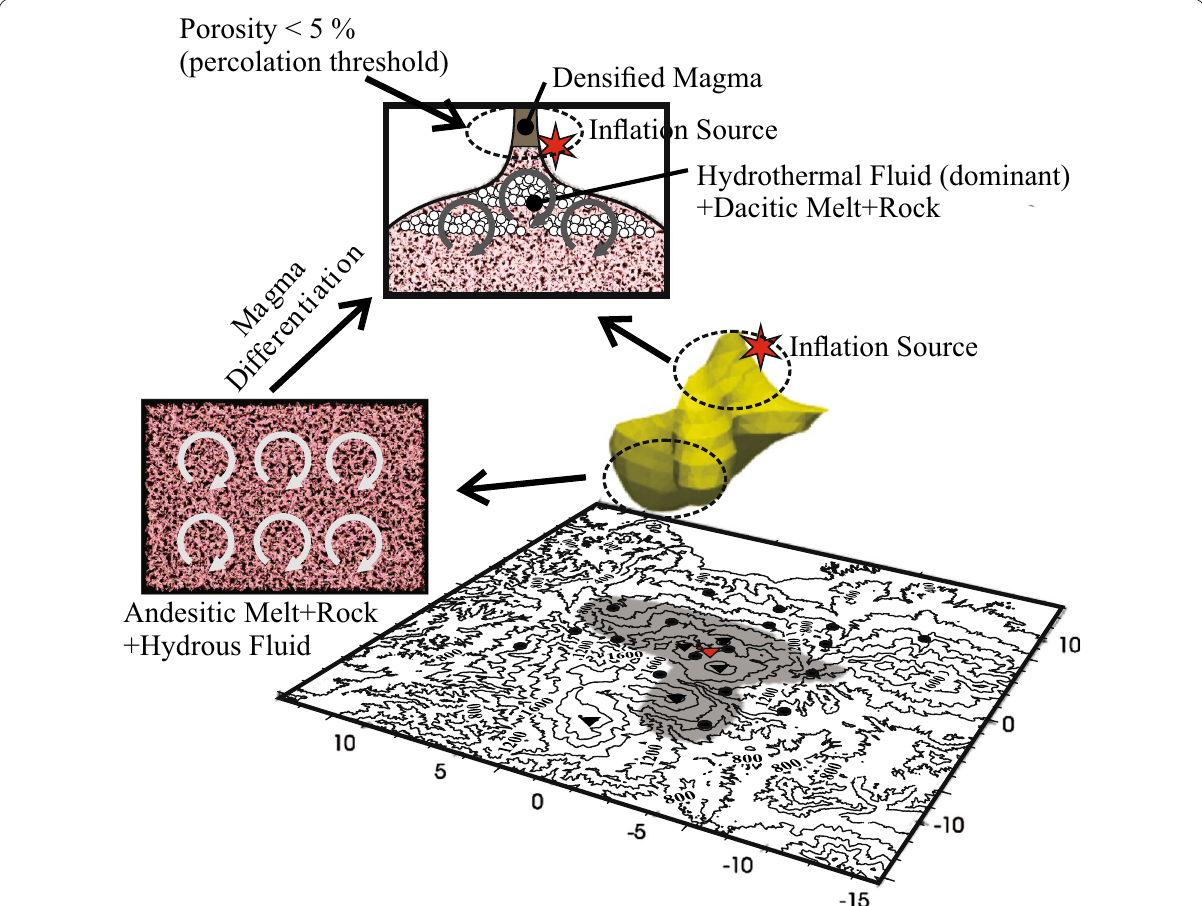
Fig. 22 Schematic diagram summarizing the main results of this study. See text for